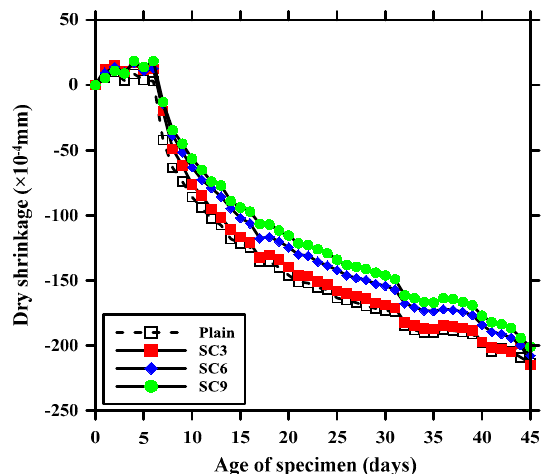
Figure 9. Change in dry shrinkage of composites according to S-CNT.